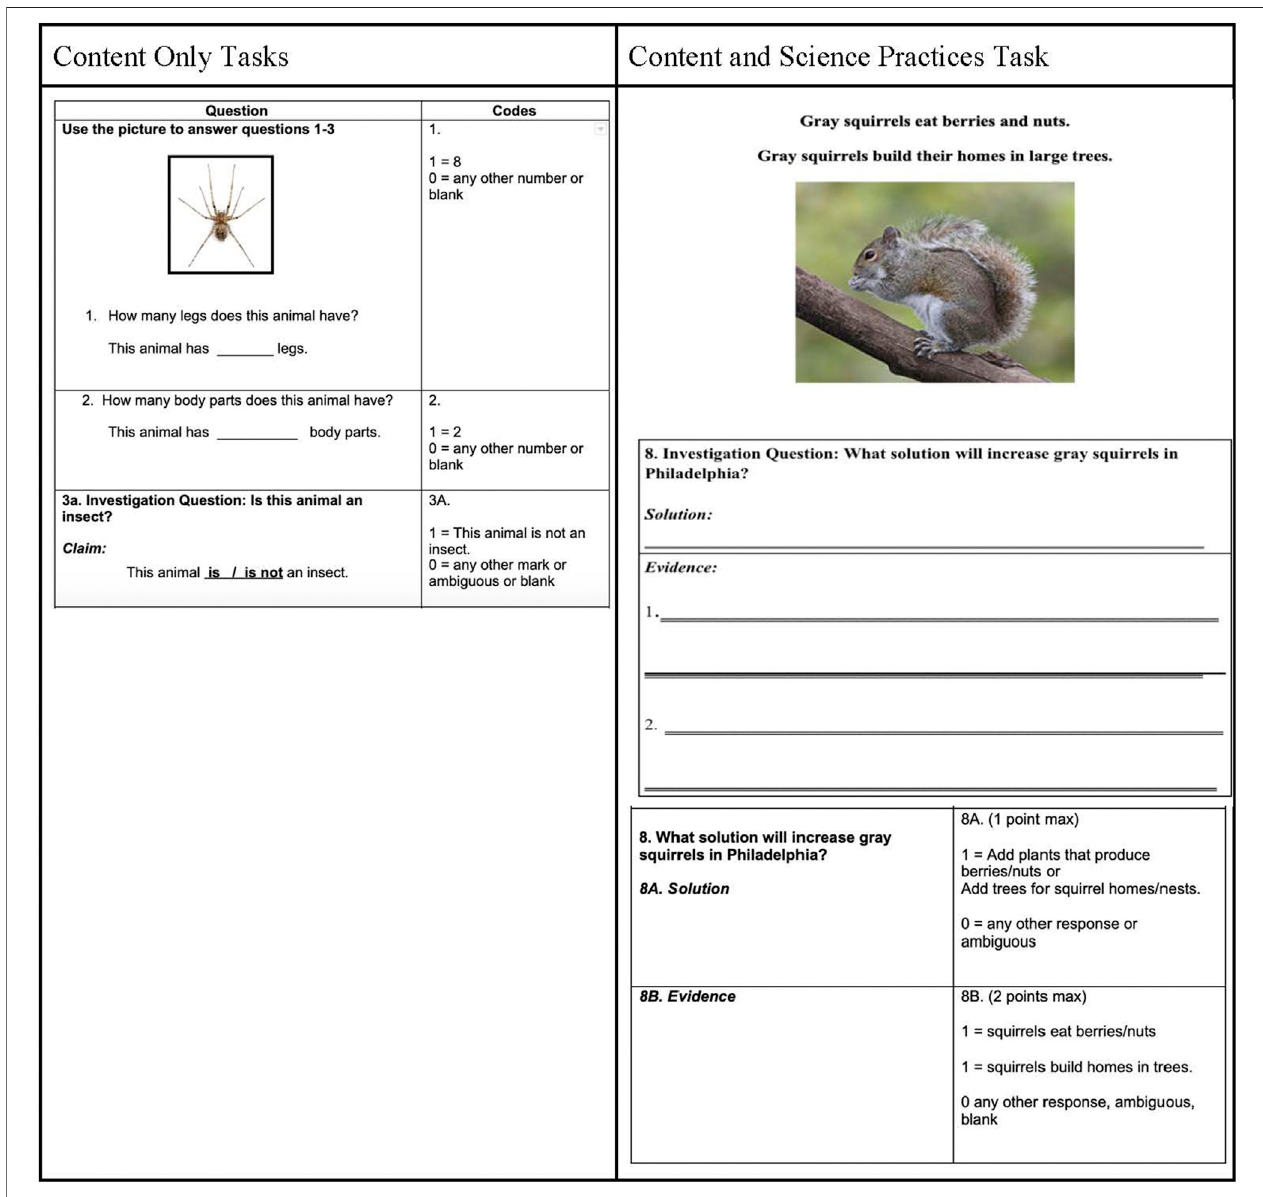
FIGURE 1 | Examples of tasks and detailed rubrics from Pre/Post